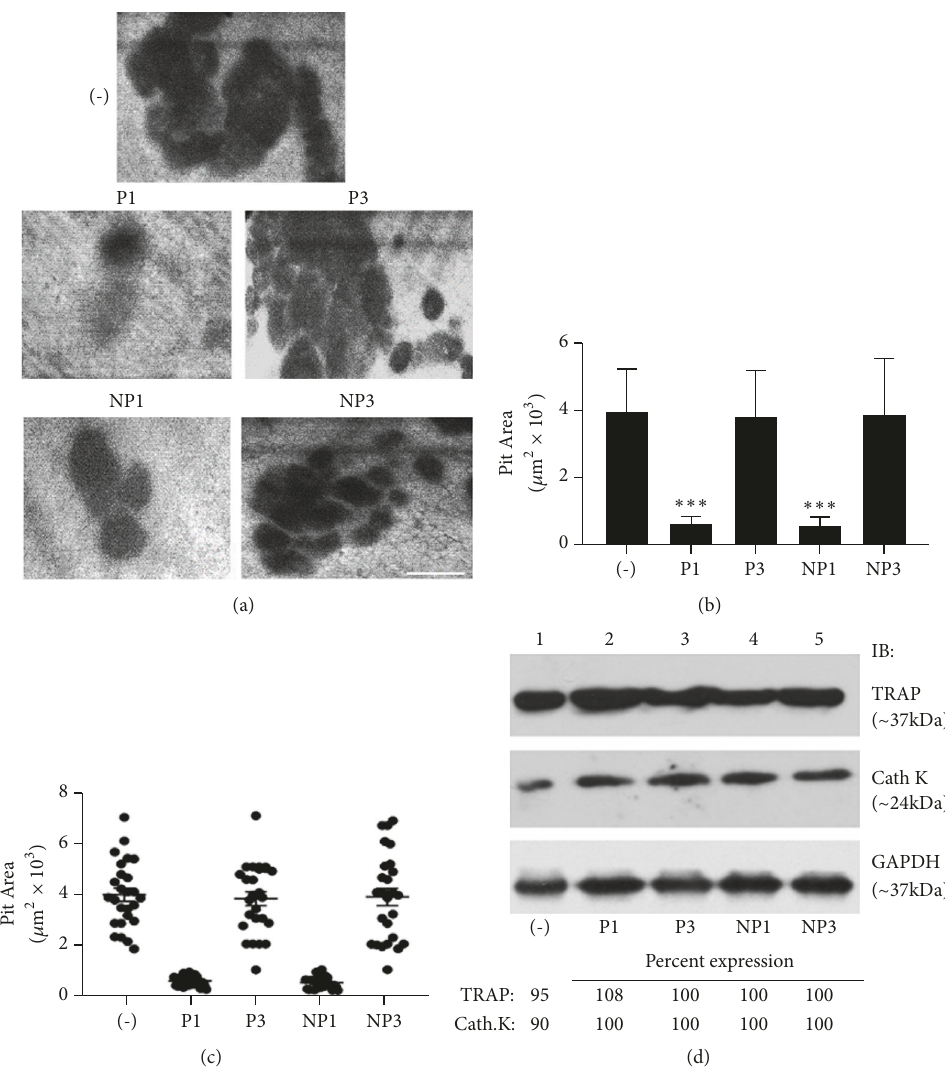
Figure 7: Resorption assay using dentine matrix and immunoblotting analyses for resorption markers . Analysis of theeffectsof transduced TAT- LPL peptides (P1 and P3) and nanoparticles (NP1 and NP3) on resorption by osteoclasts using dentine slices. (a) Osteoclasts were cultured on dentine slices for 10–12h in the presence of TNF- 𝛼 and indicated peptides. Osteoclasts untreated with any peptide but treated with TNF- 𝛼 were used as controls (-). Pits were scanned in a Bio-Rad confocal microscopy. Scale bar- 25 𝜇 m. Resorbed areas are seen as dark areas. (b) and (c) Statistic measurements of the pit area are provided as a graph: ∗∗∗ p < 0.001 versus respective controls (P3 or NP3). The resorbed pit areas (8-10 pits/slice) were quantified, and data were compiled from three dentine slices per treatment(b). The data showed in the graph is the mean ± SD of one experimentperformed. Pit area measurements are also given as scatterplots for the numberof pits scanned (c). Experiments were repeated three times with three different osteoclast preparations. (d) Immunoblotting analyses: equal amount of lysate proteins (15 𝜇 g) made from osteoclasts untreated or treated with peptides in the presence of TNF- 𝛼 and bone particles for 12-14h was used for immunoblotting analyses with TRAP (top panel) and cathepsin K (Cath K; middle panel) antibodies. Immunoblotting with a GAPDH antibody was used as a loading control (bottom panel). Experiments were repeated